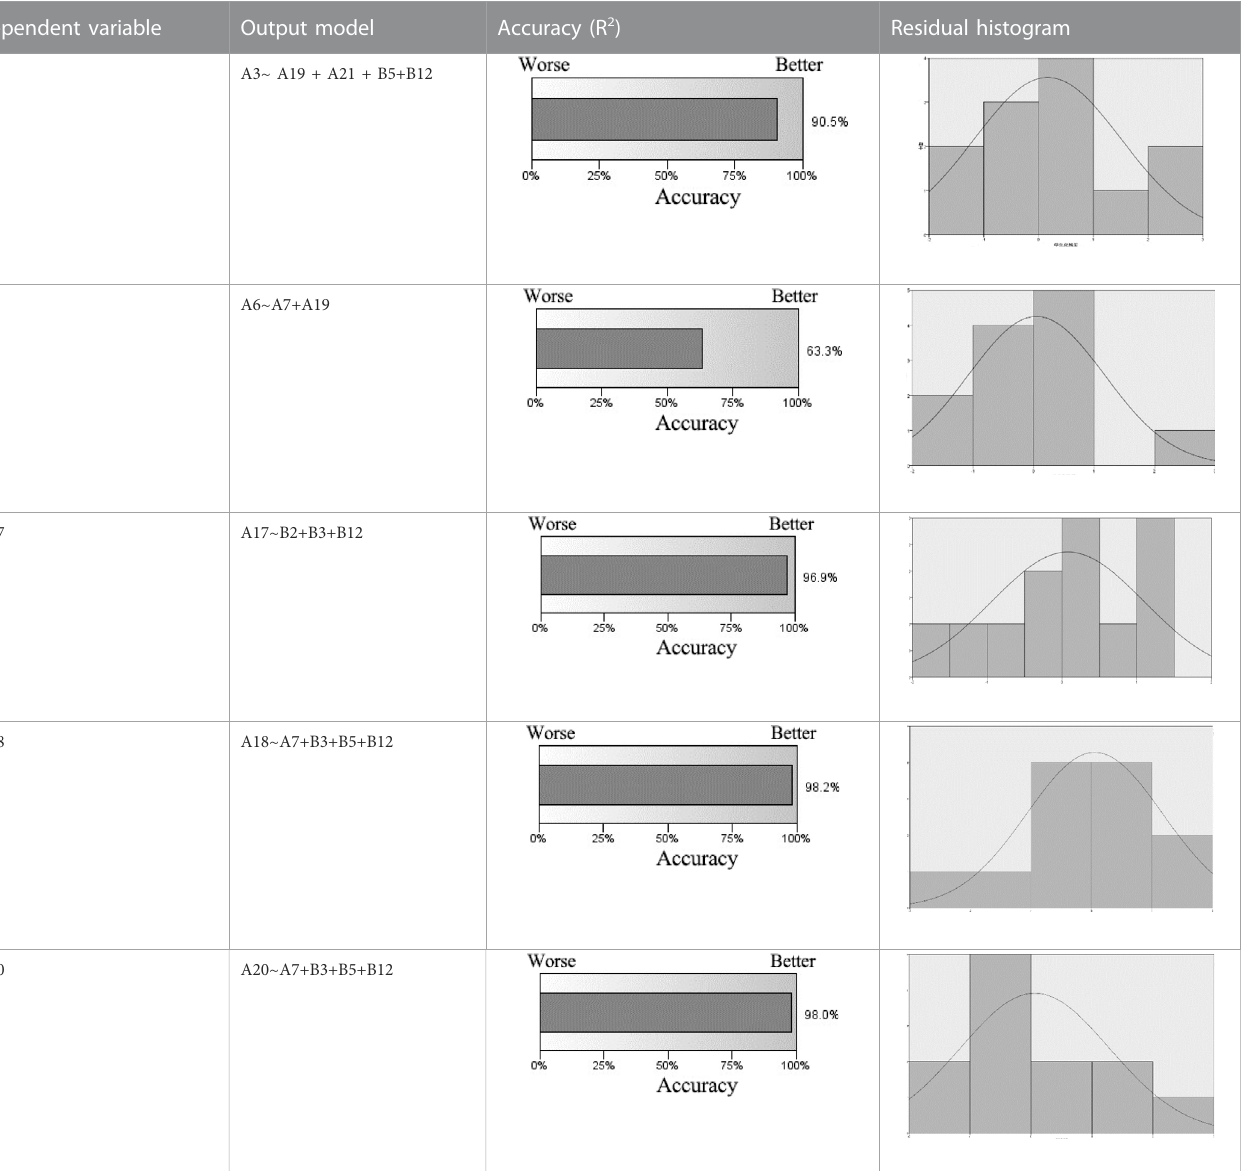
TABLE 7 Optimized output model and optimal subset regression